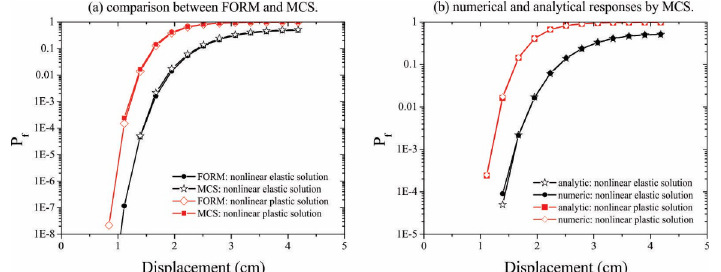
vs . displacement curve: (a) comparison between FORM and MCS (b) comparison between numerical and Figure 9. analytical responses by 𝑃𝑃 [ 𝑓𝑓 | 𝛿𝛿 ]